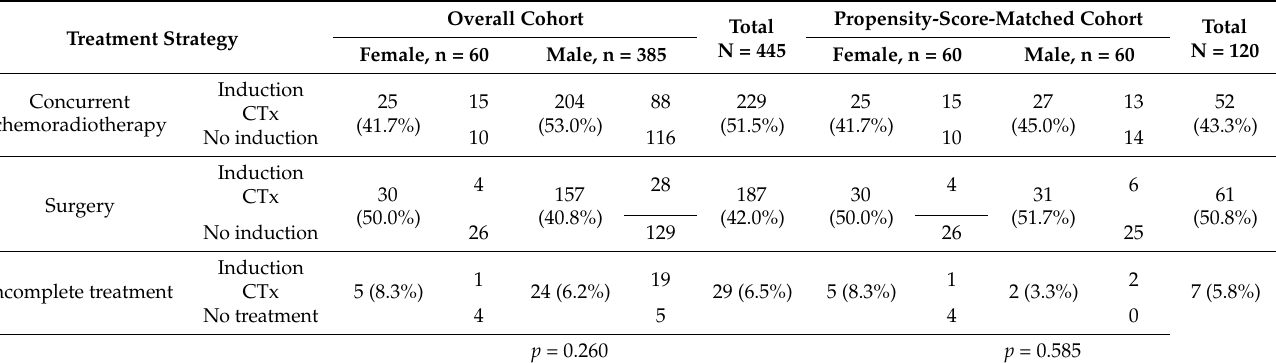
Table 2. Treatment strategies by sex.